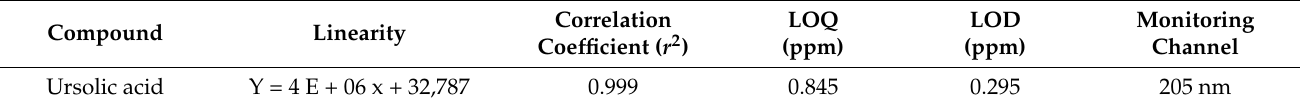
Table 4. Linearity and sensitivity of the HPLC-DAD method.